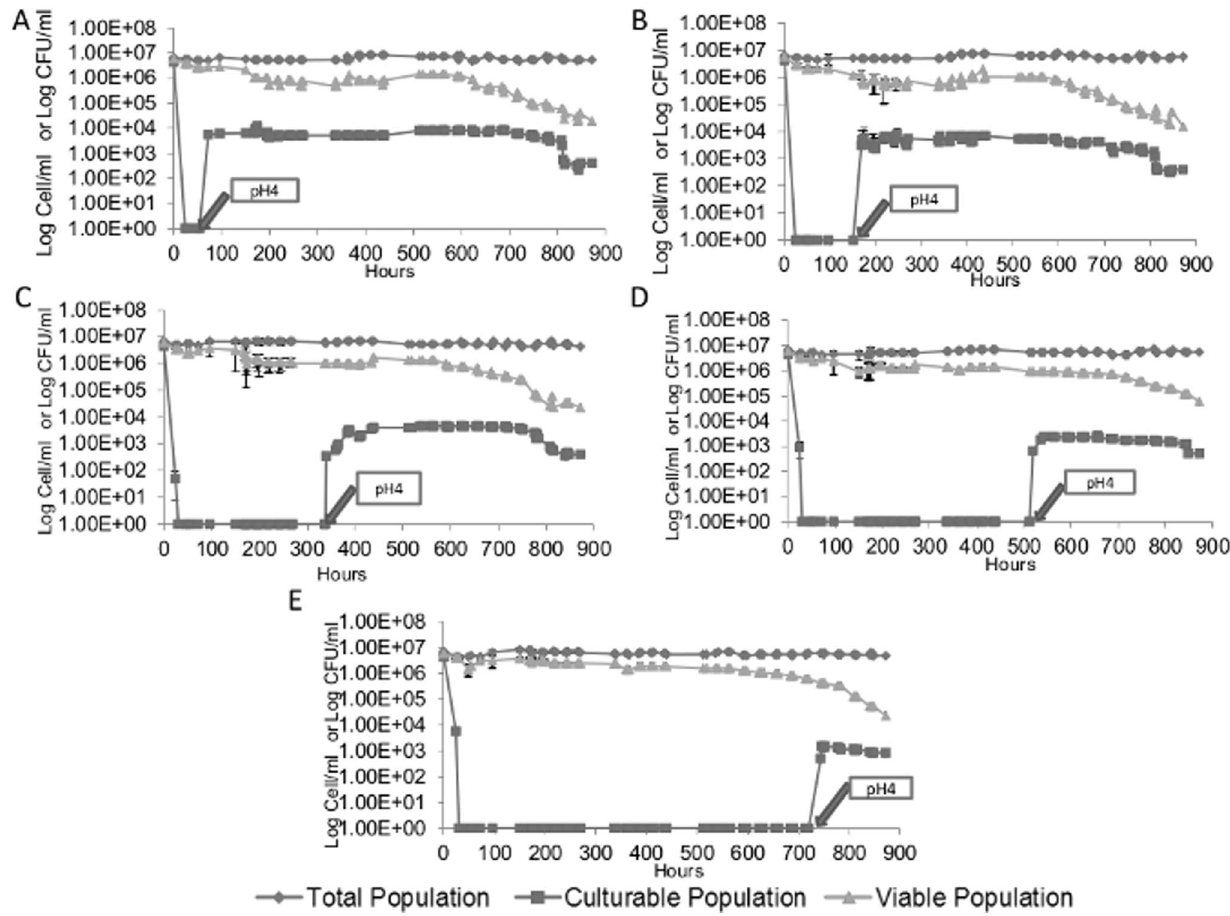
Figure 2. Resuscitation of S.cerevisiae S288C from the VBNC state. Total cell counts ( ¤ ), culturable counts ( & ), and viable counts ( m ) are shown. Resuscitation was induced by removal of the molecular SO 2 at different time intervals after entry into VBNC state (i.e. A: 3 days, B: 7 days, C: 14 days; D: 21 days; E: 30 days). Value 1 corresponds to an undetectable number (less to 10 CFU/mL). The values presented are the average of three replicates of three separate experiments.